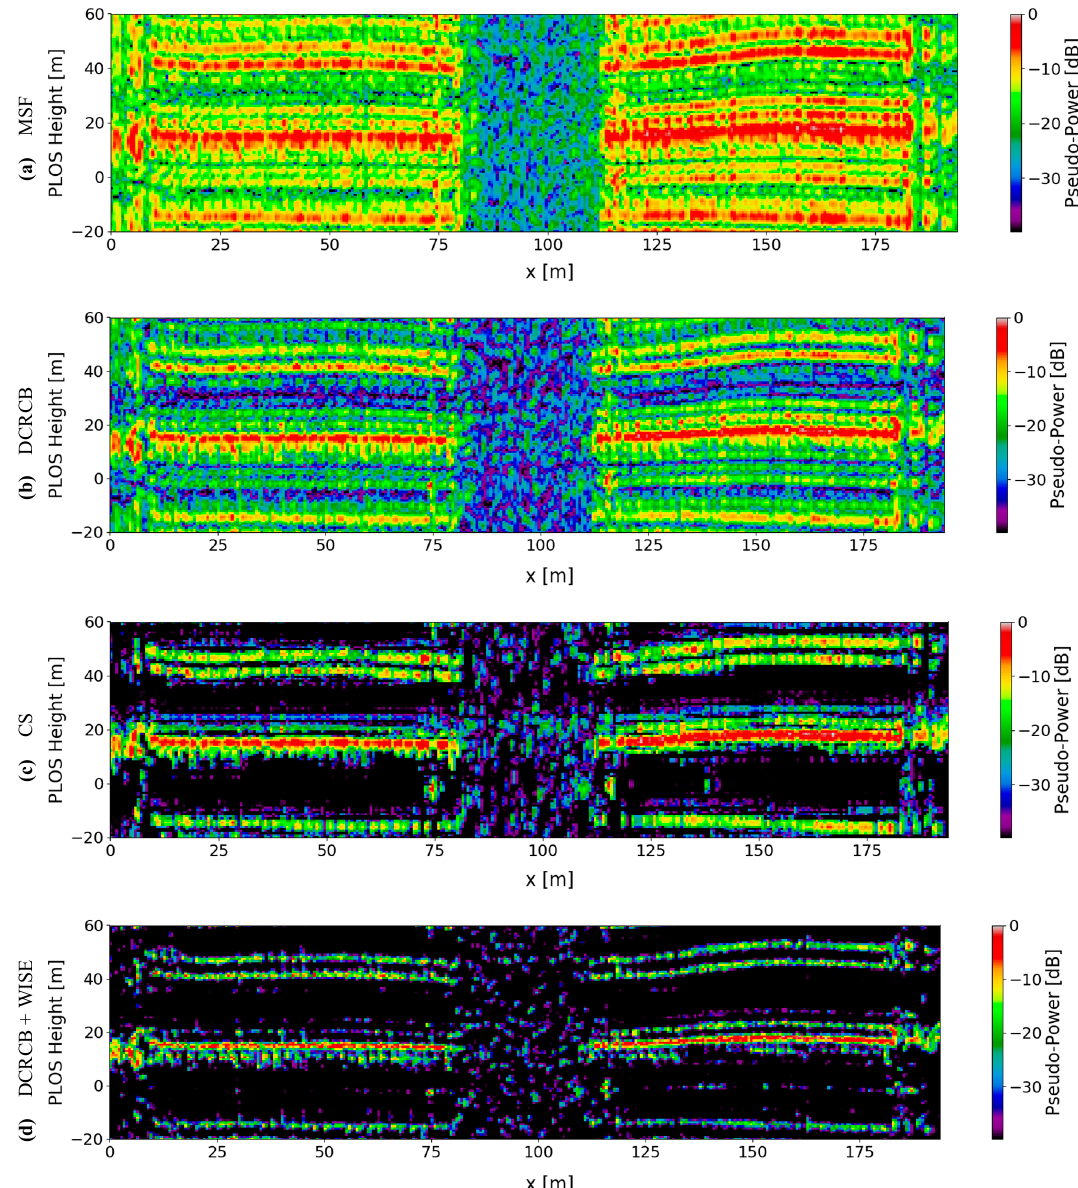
Figure 13. VV tomograms retrieved from the area depicted by the green line crossing the ROI specified in Figure 5. We perform focusing using ( a ) MSF, ( b ) DCRCB, ( c ) CS and ( d ) DCRCB + WISE. We refer to the single-look case. All tomograms are normalized with respect to the (pseudo) power recovered by MSF.